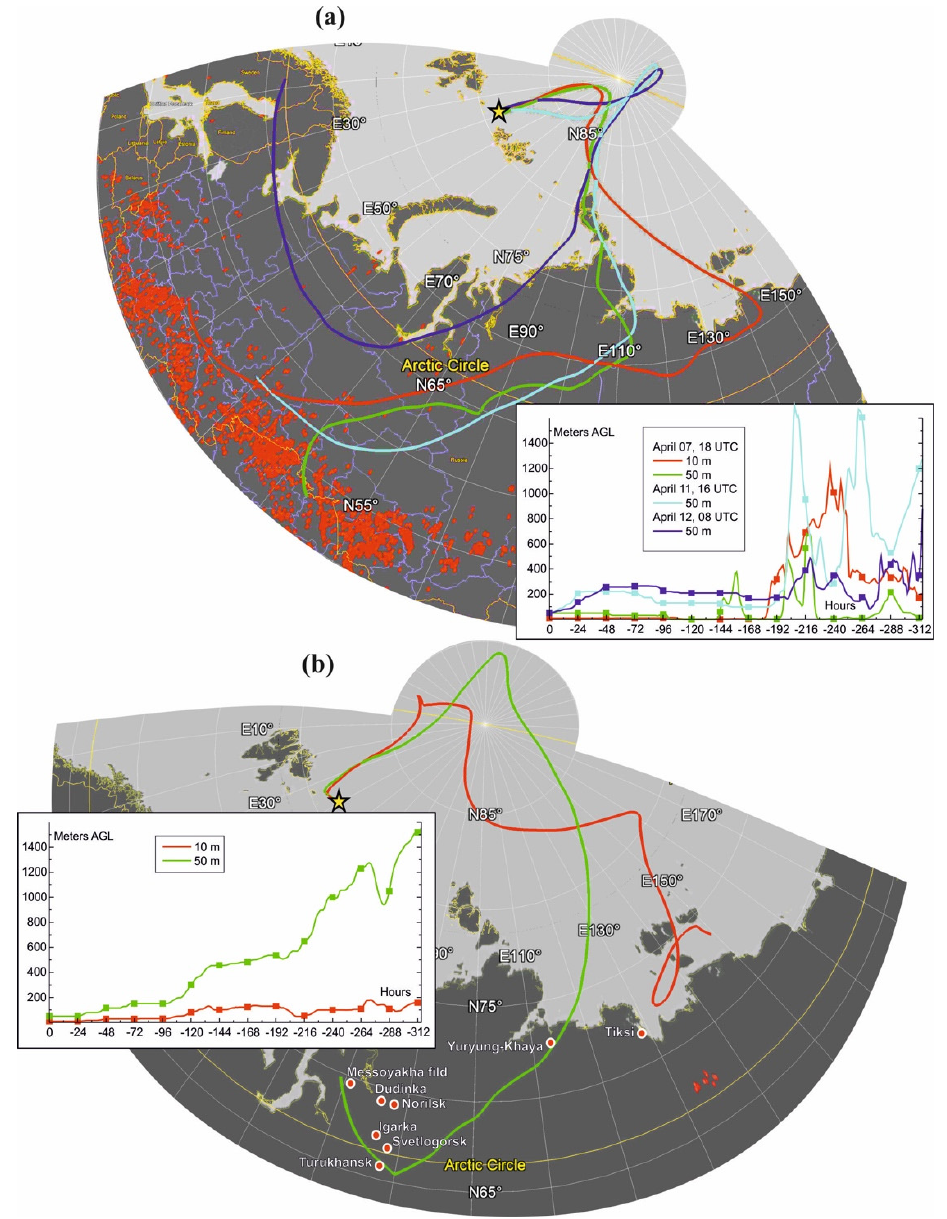
Figure 11. Back trajectories and heights above ground level (AGL) of air mass motion to the regions of measurements and fire centers: ( a ) on 7 and 11 April; ( b ) on 27–28 April.